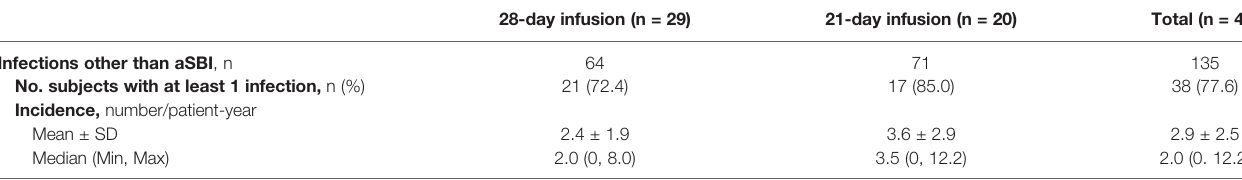
TABLE 3 | Infections other than aSBI*, intent-to-treat (ITT) population.